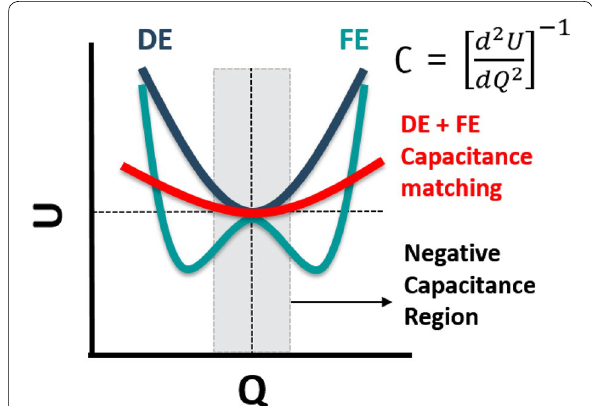
Fig. 3 Energy (U) vs. charge (Q) characteristics of ferroelectric capaci- tor. The navy, green, and red-colored curve represents the U vs. Q curve of dielectric capacitor, ferroelectric capacitor, and capacitance- matched capacitor (i.e., the capacitor which is composed as the series connection of dielectric and ferroelectric capacitor), respectively. By capacitance-matching, the total U vs. Q curve has single energy minimum region, and thereby the hysteresis of ferroelectric capacitor no longer